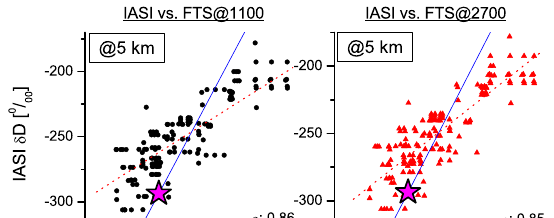
FTS H 2 O concentrations for the altitudes marked in the left panel of Fig. 12 by the black thick dots and the red triangles: 3 , 5 , and 9 km. For both FTS retrievals the correlation coef- ficients are situated between 0 . 84 and 0 . 89 . Table 5 collects